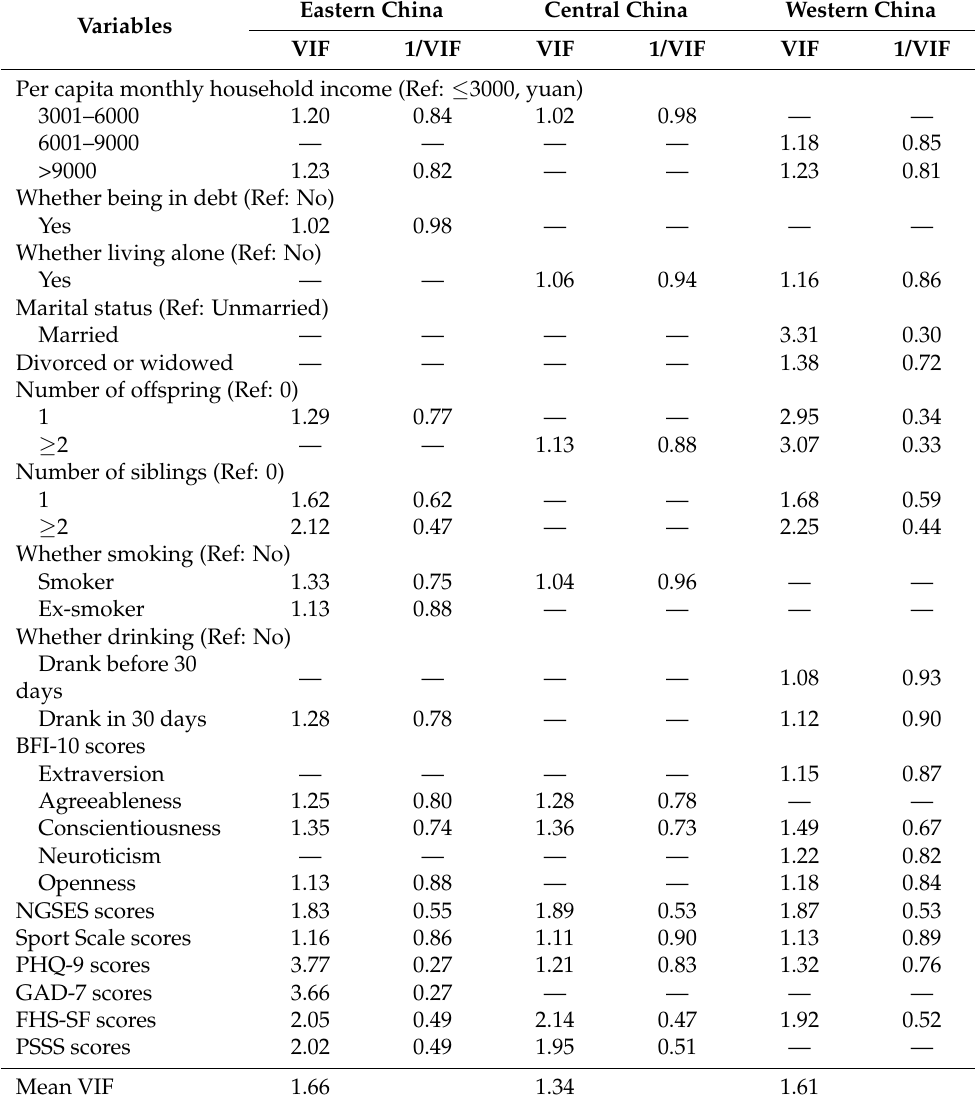
Table A9. The stepwise regression of associated factors for EBS-SF Scores stratified by place of residence. Urban Rural Variables Coef. β p